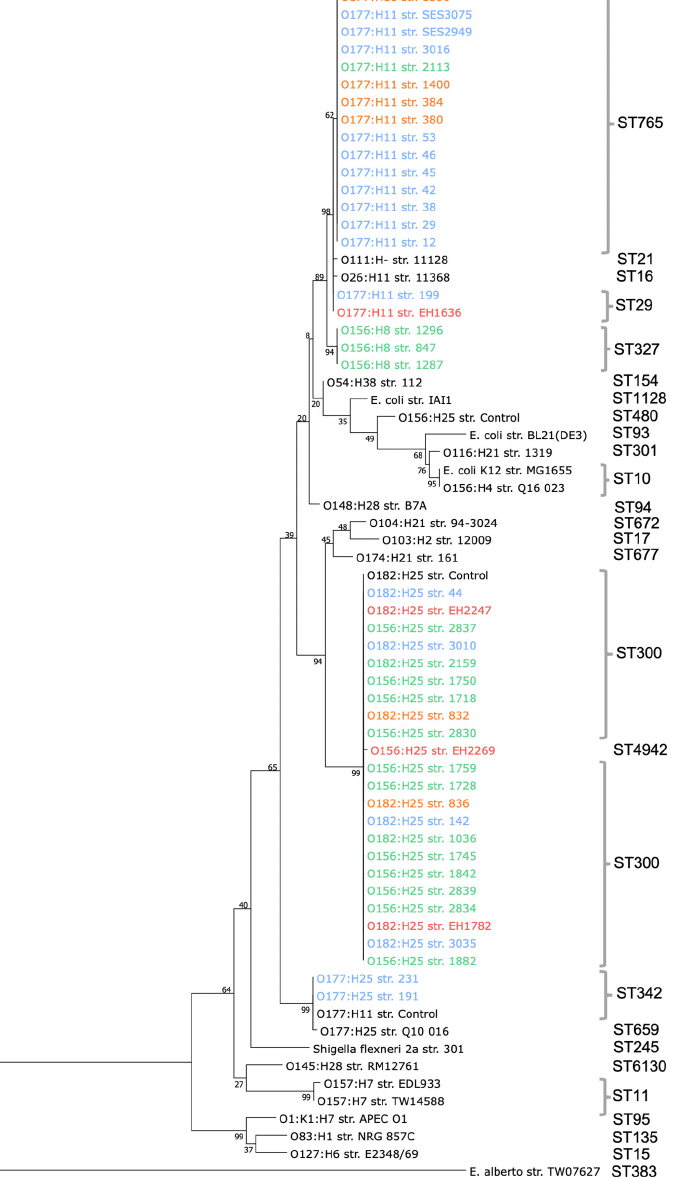
Figure 2. Phylogenetic tree of concatenated MLST gene alleles ( adk , fumC , icd , gyrB , mdh , purA , and recA ) extracted from the O156, O177. and O182. healthy cattle, diarrheic calves, dairy calves, and humans whose sequences of 3424 were compared to other strains based on [4,19]. The evolutionary history was inferred by using the Maximum Likelihood method based on the Tamura–Nei model and 1000 bootstrap replicates [18]. The percentage of trees in which the associated taxa clustered together is shown next to the branches.